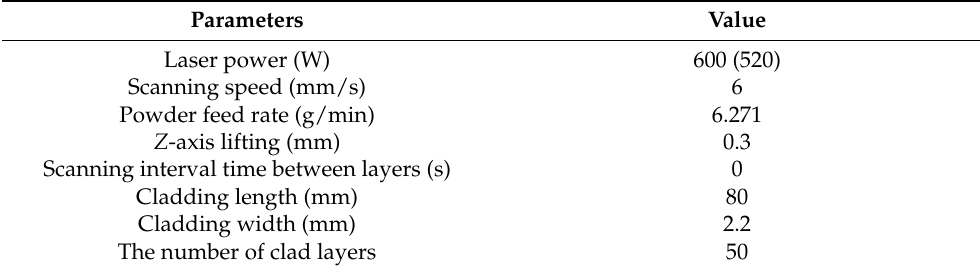
Table 3. Laser cladding parameters of 316L stainless steel thin-walled